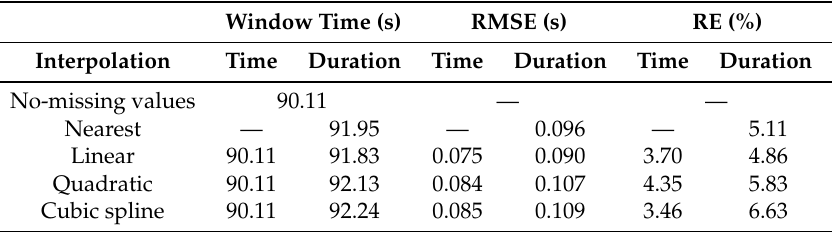
Table 1. Difference between duration and time interpolation by using different approach (i.e., no-missing values, nearest neighbor, linear, quadratic, and cubic